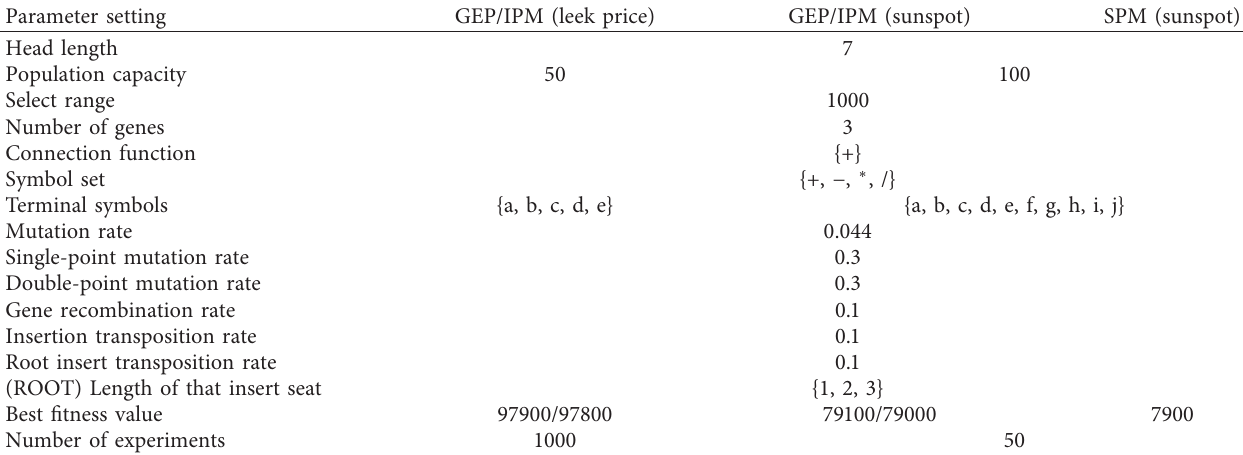
Table 1: GEP and DM_GEP comparison test parameter settings.